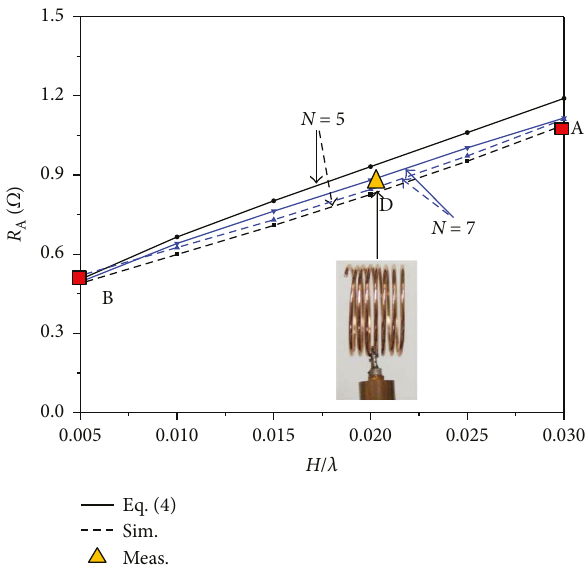
Figure 5: Comparisons of NMHA input resistance in free